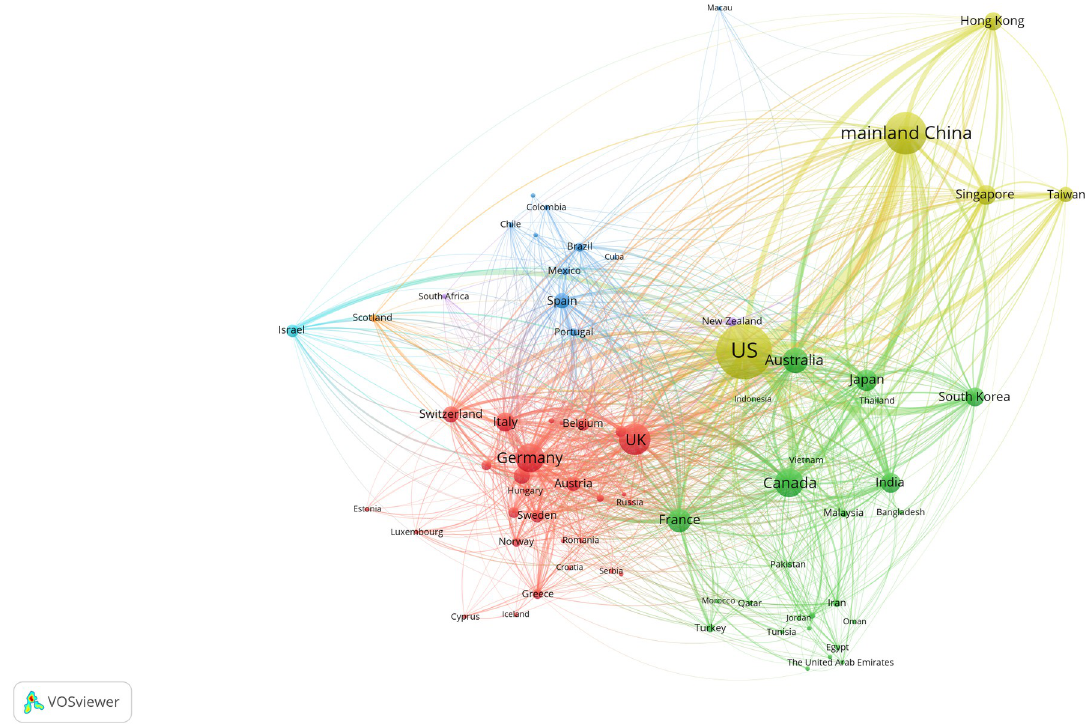
Fig 2. International scientific collaboration network in 1993–2013.